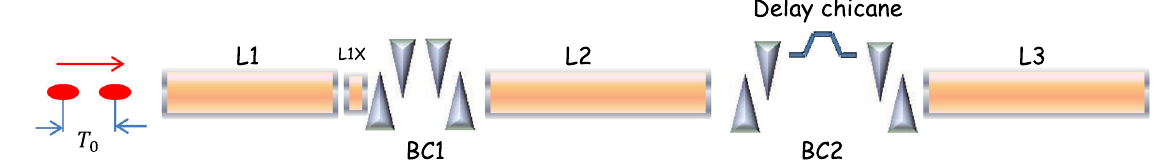
FIG. 4. A schematic layout of the LCLS beam line to generate the twin bunches (not to scale). The red ellipses are the electron beams after the injector. The delay chicane is inserted in BC2.